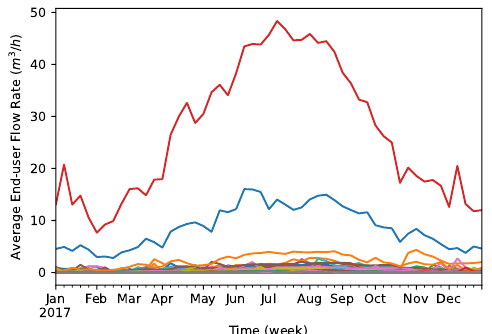
Figure 8. Distribution of the flow rate values at InfraQuinta, 2017.